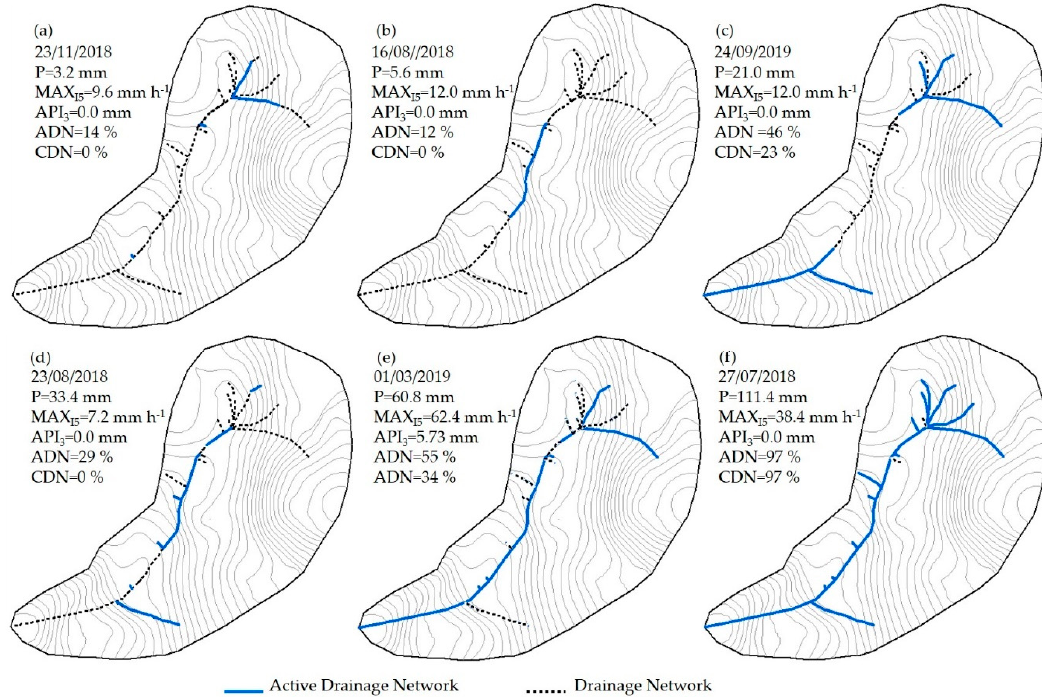
Figure 3. Total length of the active drainage network for di ff erent precipitation events. ( a ) Low active drainage network. ( b ) Only the intermittent section was active. ( c ) Ephemeral flow in di ff erent locations. ( d ) High ADN but no connection. ( e ) High precipitation intensity with inactive channels. ( f ) Maximum AND and CDN. Events are organized from lowest to highest total precipitation. For each event, total precipitation (P), maximum 5-min precipitation intensity (MAX I5 ), API 3 , active drainage network (ADN), and connected drainage network (CDN) are shown.